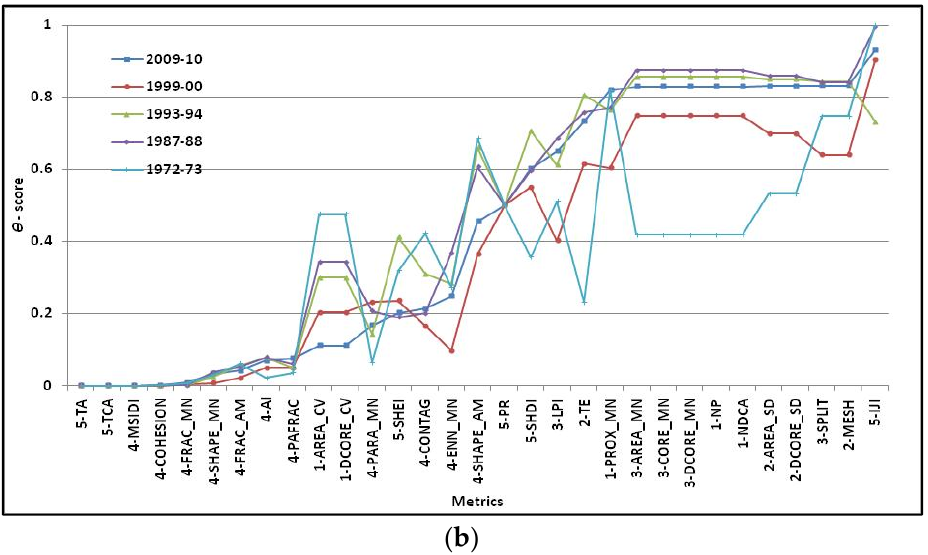
Figure 6. ( a , b ) θ -score of landscape metrics for the Liverpool Range and Liverpool Plains, respectively, in different years (number before metric indicates cluster number, see Section 4.1). (See Table 1 for details of each metric).